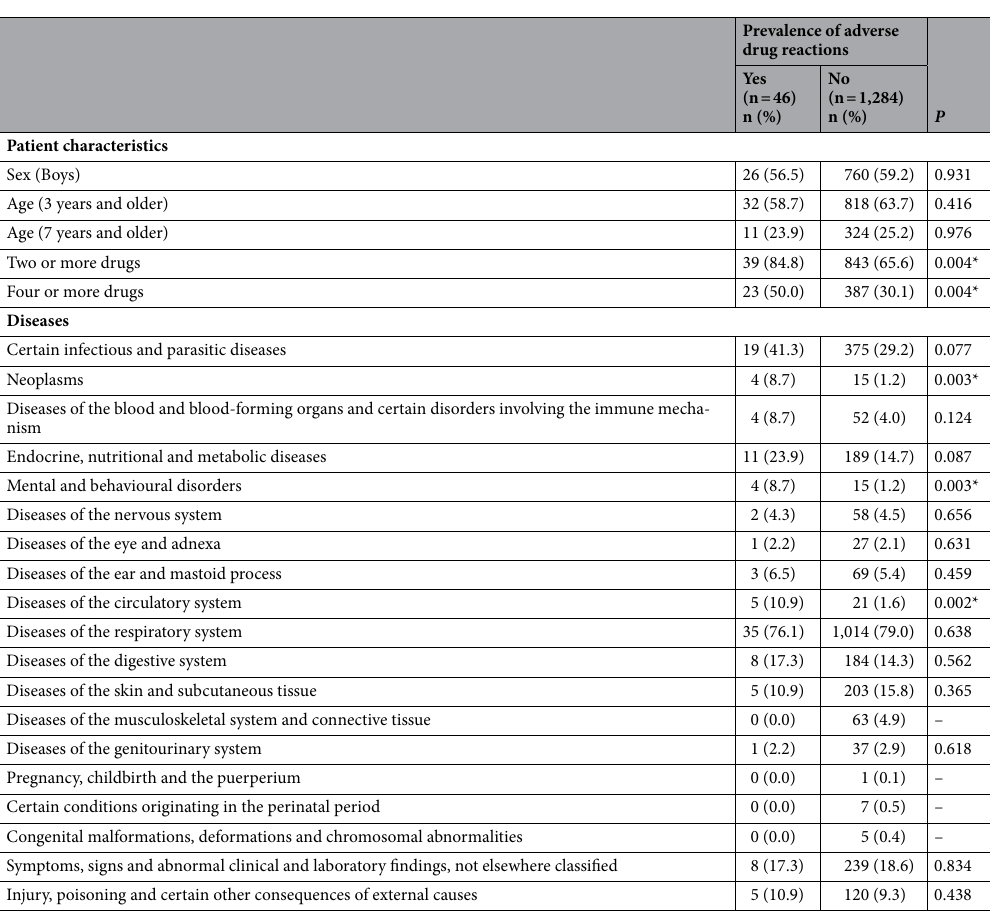
Table 4. Results of the univariate analysis. Fisher’s exact test. * P < 0.05.